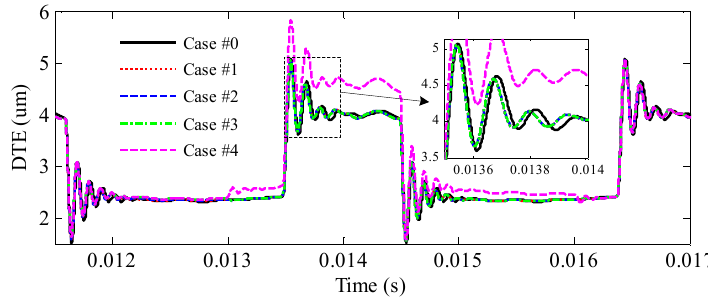
Figure 12. Effects of surface crack propagation on time domain of DTE. The effects of surface crack propagation on DTE spectra are also studied and presented in Figure 13. It is observed that the side frequency components appear near the mesh frequency f m and its harmonic frequencies (2 f m , 3 f m , . . . ) in the spectrum diagrams of four fault cases, and the amplitudes of side frequency go up gradually with the surface crack propagation. In addition, the interval of the two adjacent side frequency components equals to the rotation frequency f n of the driving gear. It can be concluded that the surface crack propagation has a small influence on the time domain of DTE, but an obvious influence on the sideband components of the DTE spectrum, which is an important feature for the diagnosis of early spalling failure.